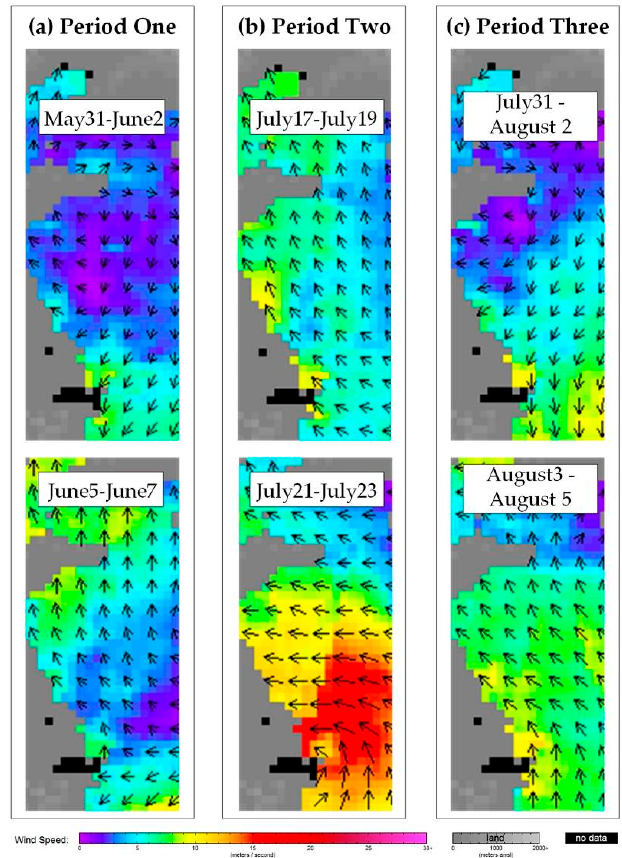
Figure 16. Three-day average surface wind speed and direction of three periods of oblateness change in 2018, obtained from RSS. In each specific period, the upper sub-graph represents the sea-surface wind (SSW) at the starting time, and the lower vector graph shows the changes in wind speed and direction within this period. ( a ) The change of SSW in period one. ( b ) The change of SSW in period two. ( c ) The change of SSW in period three.